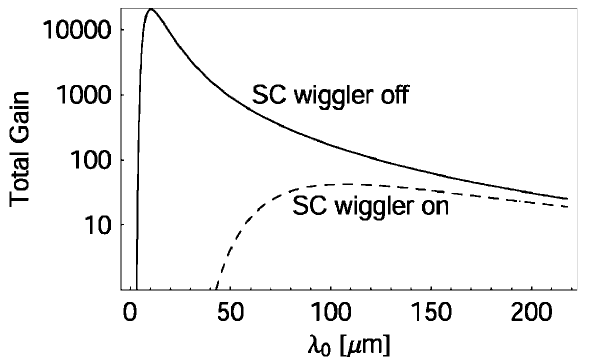
FIG. 6. LCLS FEL power gain length as a function of the uncorrelated energy spread (cid:27) at 14 GeV.